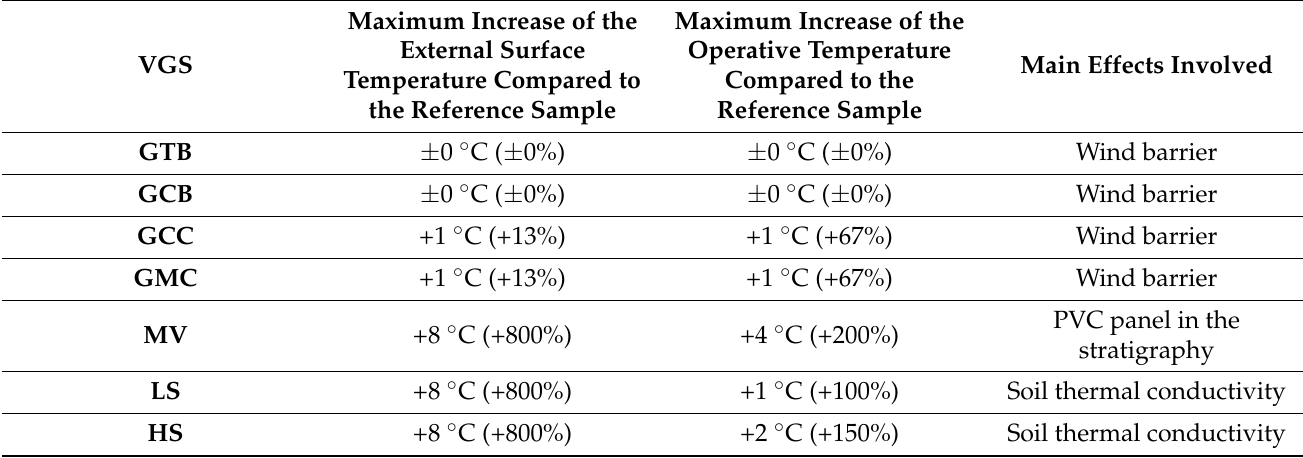
Table 6. Winter. Comparison of the results obtained on the south wall of the sample during the daytime and evaluation of the variables involved for each